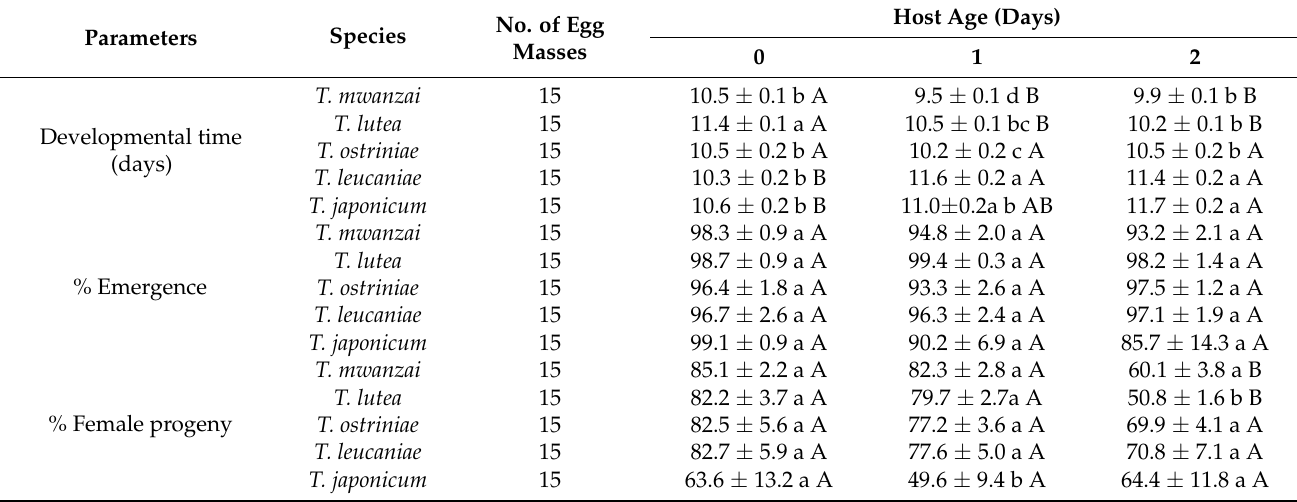
Table 2. Comparisons of developmental time, percent emergence, and percent female progeny of the five parasitoid species on FAW eggs of different